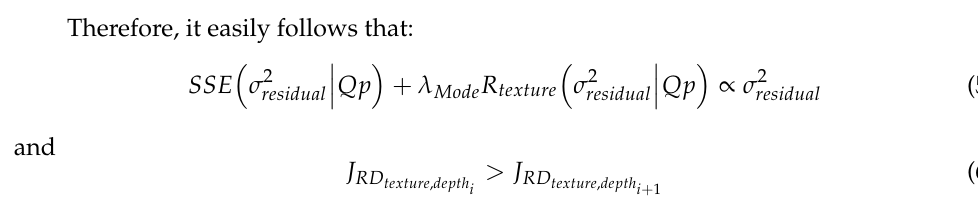
Figure 2. Relationship between the variance of residual and both SSE and rate of CU for Class A sequence “Traffic” (Qp = 27).